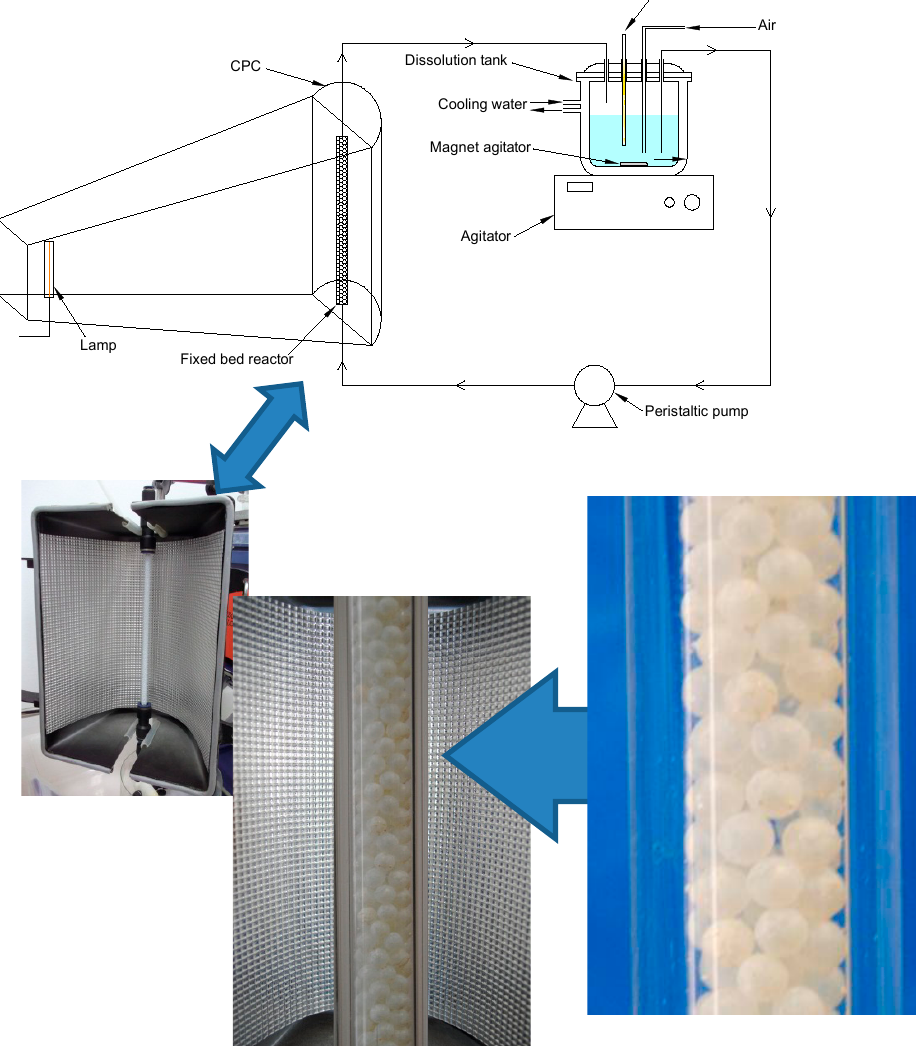
Figure 5. Packed-bed photoreactor system and glass spheres photocatalytic bed in